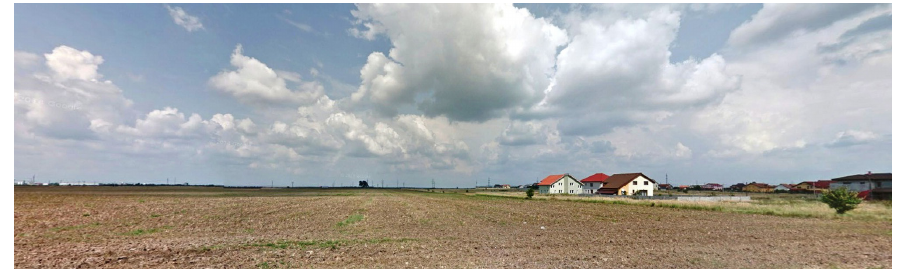
fig. 5a. Sprawl in the suburban zone of Timisoara in Romania. Sînandrei commune. Source: the